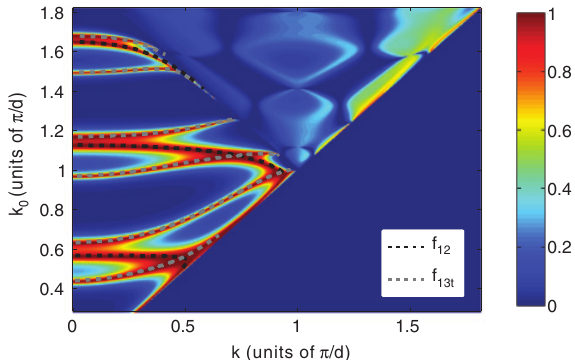
Figure 5: Dispersion curves of the MIM structure with dimensions = h = 1.6 d , a = 0.25 d , and h h 1 3 sents the resonance condition for the f line for the f 13 t